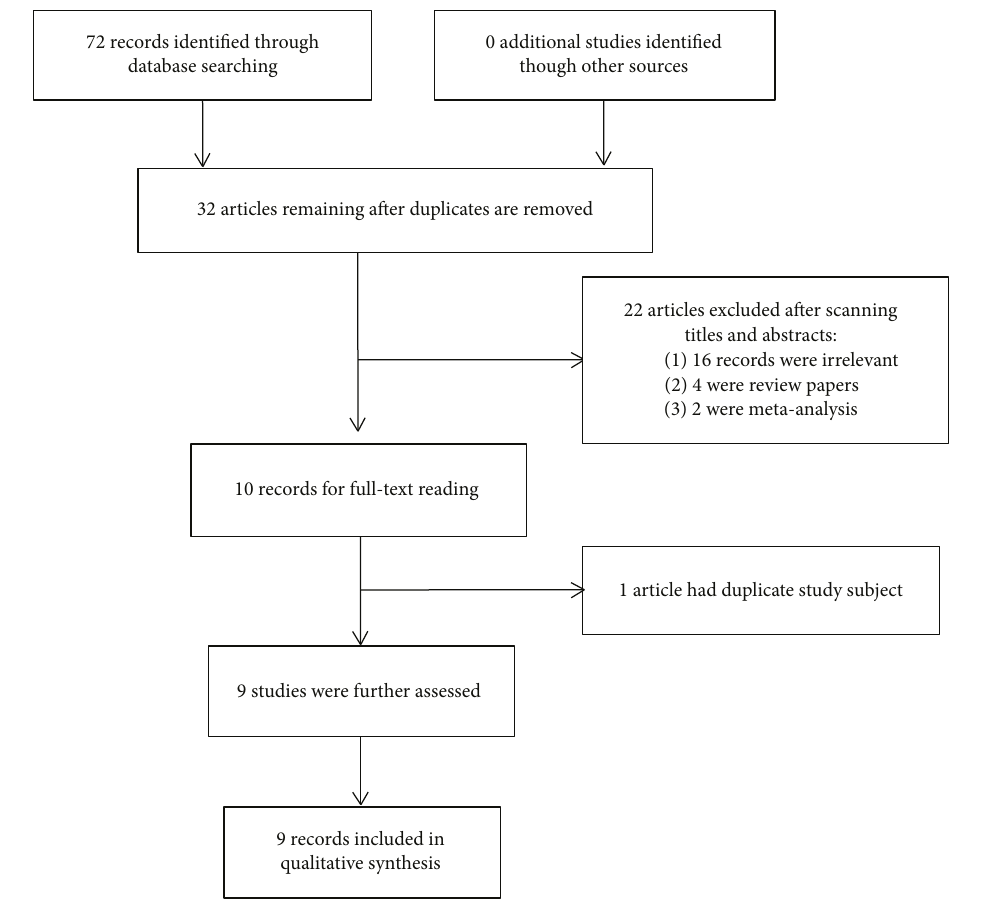
Figure 1: Flow diagram of searching procedure. Table 1: Characteristics of the included